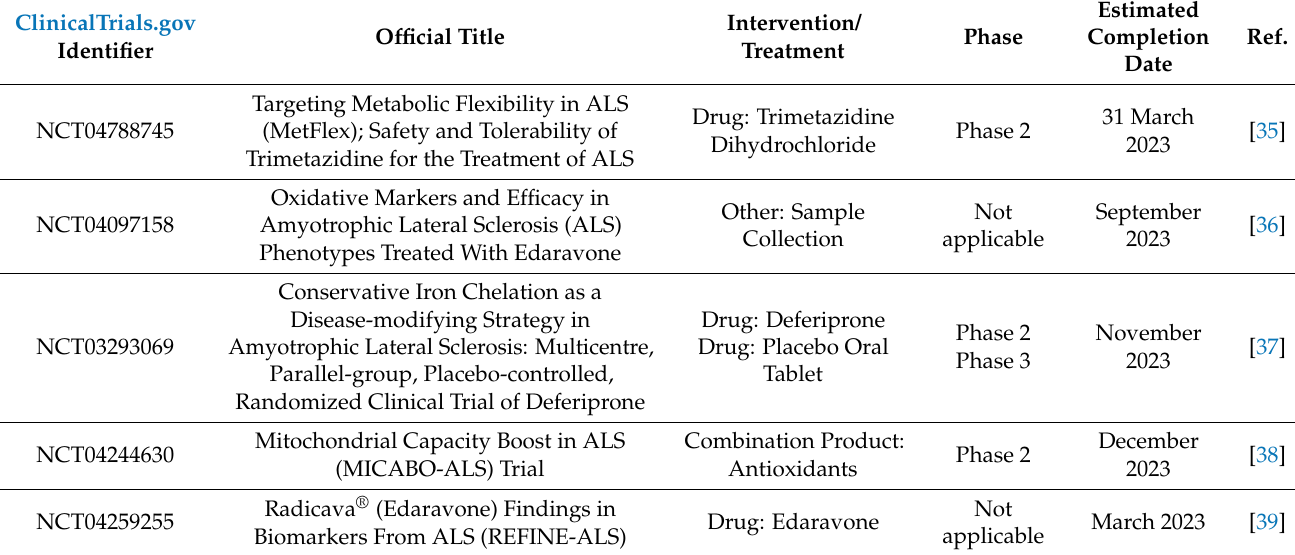
Table 2. Summary of active clinical trials investigating amyotrophic lateral sclerosis in relation to oxidative stress. The studies have been retrieved from clinicaltrials.gov with search keywords “Condition or disease = Amyotrophic lateral sclerosis” and “Other terms = oxidative stress” and selecting the items with the status “Recruiting” and “Active, not